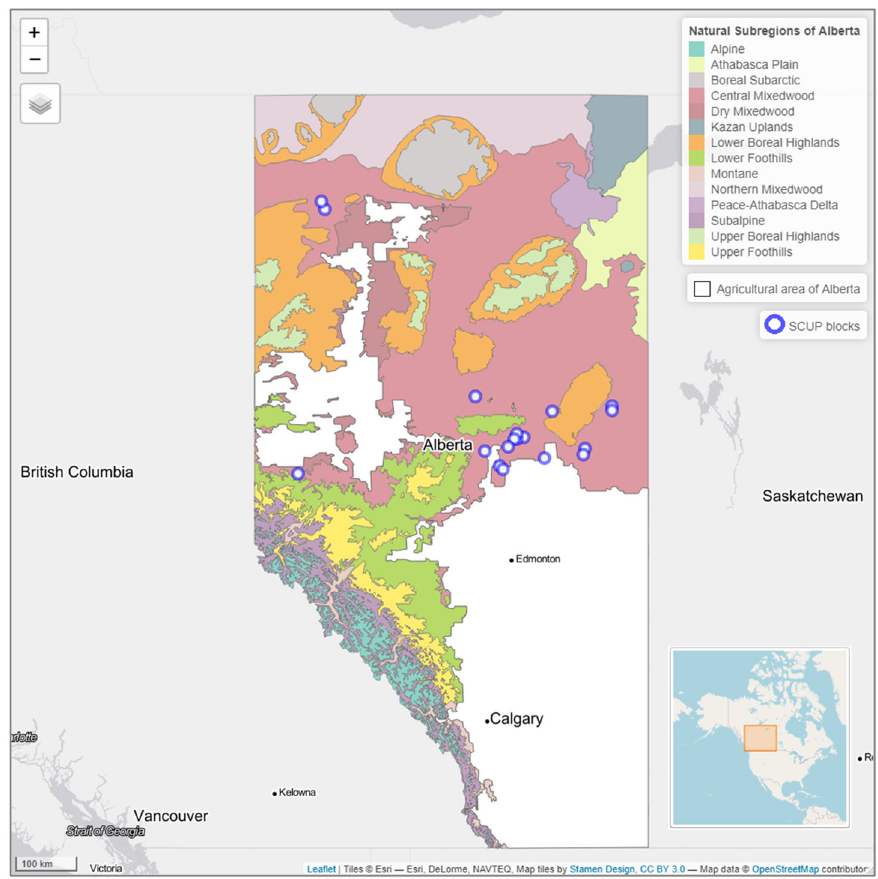
Figure 1. Locations of the 18 SCUP blocks across Natural Subregions of Alberta. Sites were located across a climatic gradient with mean annual temperature ranging from − 0.3 to 2.5 ◦ C, mean annual precipitation from 432 to 506 mm, and climate moisture index from − 0.4 to 3.3 (Table 1). Climatic conditions for the 1981–2010 period were obtained from ClimateNAv6.11 [17] with the Climate Moisture Index (CMI) calculated following methods described by Hogg et al. (2013) [18]. Elevation of these 18 blocks ranges from 362 to 766 m a.s.l. and slope 0% to 20% (85 plots within 10% slope), with all topographic positions represented in the dataset. According to field-determined ecosites [19], 83 plot clusters are situated in ecosite d (low-bush cranberry) and 9 in ecosite e (dogwood) of the Central Mixedwood Natural Subregion of Alberta [20]. Soils assessed for a subset of the 60 plots show typical conditions for boreal mixedwoods with mesic to subhygric soil moisture regime and medium to rich soil nutrient